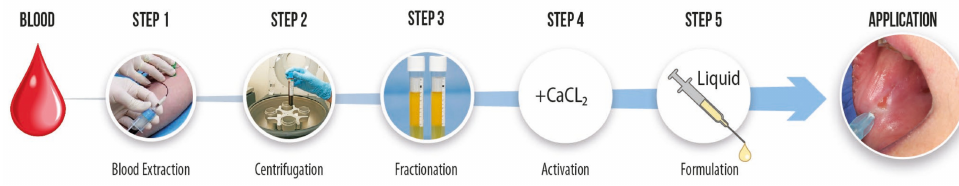
Figure 2. PRGF preparation protocol for the treatment of MMP oral